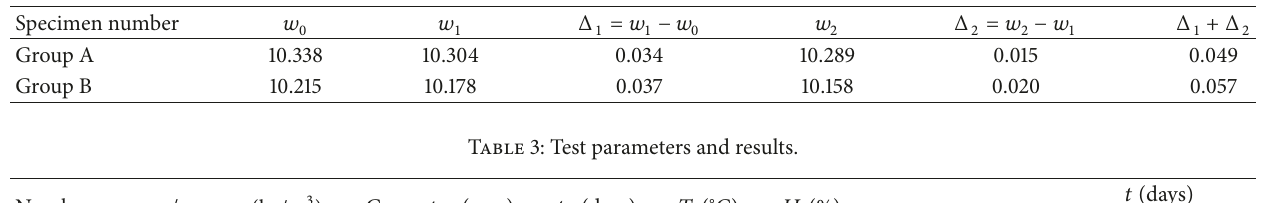
Figure 5: Comparison of shrinkage strain. Table 2: Average weights of specimens (kg).